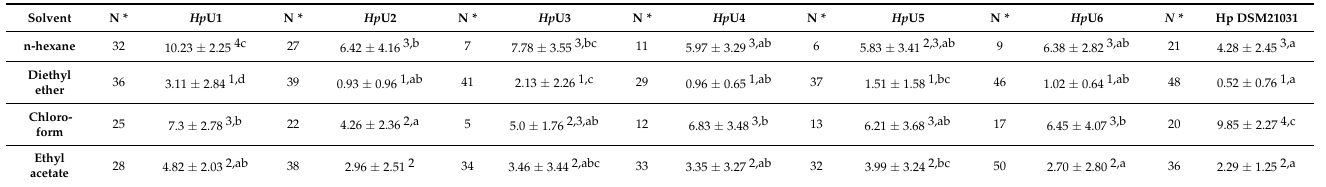
* Number of samples with inhibitory effect out of 50 oregano honey tested samples. Different superscript numbers indicate statistically significant differences in rows while superscript numbers indicate statistically significant differences in columns (ANOVA with Tukey’s HSD post hoc comparisons at 95%).